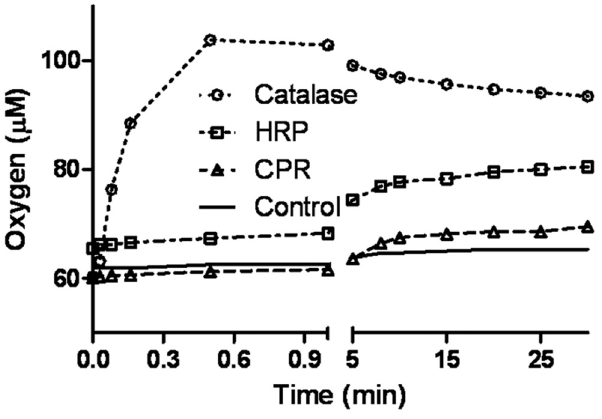
Figure 4. The effect of a radical scavenger in CPR mediated peroxide depletion.